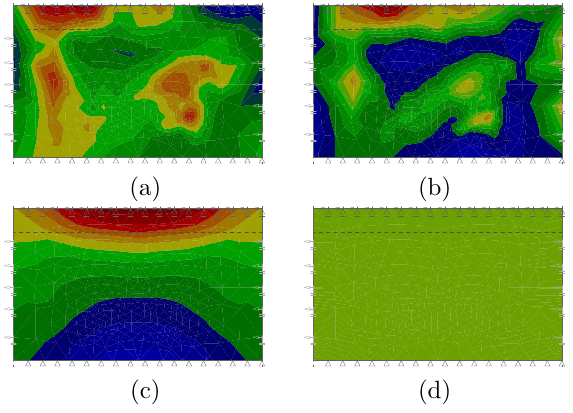
Figure 7. a) Total shear strain - variable stiffness and MC model, b) Equivalent plastic strain - variable stiffness and MC model, c) Total shear strain - variable stiffness and elastic model, d) Total shear strain - constant stiffness with the layer and elastic model.